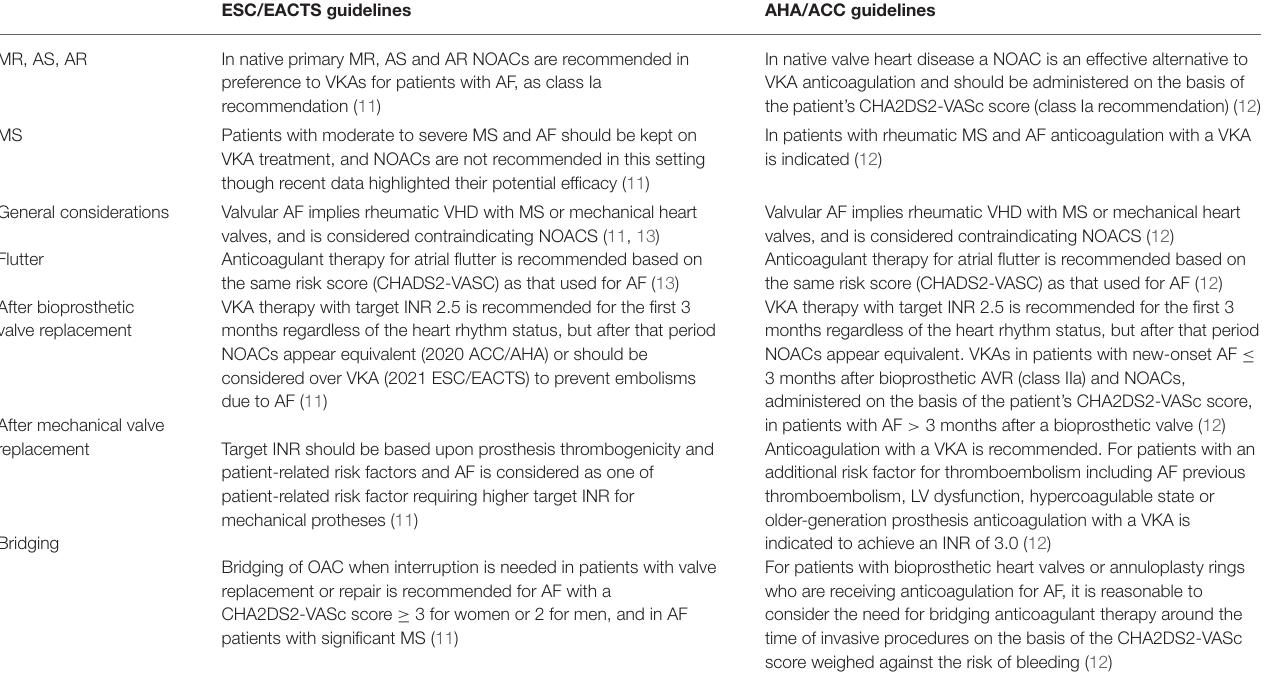
TABLE 3 | Considerations for anticoagulation therapy in patients with VHD and AF according to the ESC/EACTS and AHA/ACC guidelines. ESC/EACTS